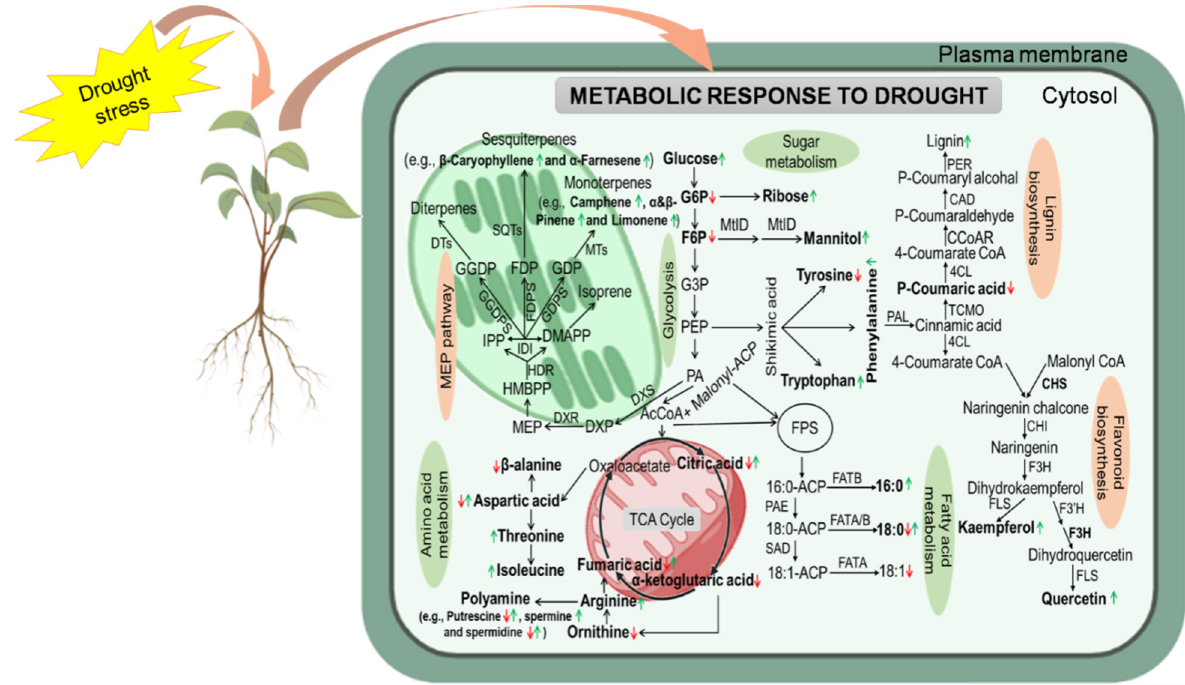
Figure 1. A schematic representation of metabolic response to drought stress. Primary metabolites (PMs) and secondary metabolites (SMs) are reprogrammed in plant cells to maintain osmotic balance and activate various primary and secondary metabolic pathways (green and orange circles, respectively) to survive under DS. Metabolites with an important role in DS are highlighted in bold, and their responses are depicted with green arrow (increased level), red arrow (decreased level), and green and red arrows (increased/decreased levels). ACP, acyl carrier protein; 4 CL, 4-coumarate-CoA ligase; AcCoA, acetyl-CoA; CAD, cinnamyl alcohol dehydrogenase; CCoAR, cinnamoyl-CoA reductase; CHI, chalcone isomerase; CHS, chalcone synthase; DMAPP, dimethylallyl diphosphate; DTs, diterpene synthase; DXP, 1-deoxy-D-xylulose-5-phosphate; DXS, 1-deoxy-D-xylulose 5-phosphate synthase; FAT A/B, fatty acyl-ACP thioesterase A/B; F3H, flavanone 3-hydroxylase, F3’H, flavonoid 3‘-hydroxylase; F6P, fructose 6-phosphate; FDP, farnesyl diphosphate; FDPS, farnesyl diphosphate synthase; FLS, flavonol synthase; G3P, glyceraldehyde 3-phosphate; G6P, glucose 6-phosphate; GDP, geranyl diphosphate; GDPS, geranyl diphosphate synthase; GGDP, geranyl geranyl diphosphate; GGDPS, geranyl geranyl diphosphate synthase; HDR, 1-hydroxy-2-methyl-2-(E)-butenyl 4-diphosphate reductase; HMBPP, 1-hydroxy-2-methyl-2-(E)-butenyl 4-diphosphate; IDI, isopentenyl diphosphate isomerase; IPP, isopentenyl diphosphate; MtID, mannitol-1-phosphate dehydrogenase; MEP, 2-C-methyl-D-erythritol-4-phosphate; MTs, monoterpene synthase; PAE, palmitoyl-ACP elongase; PA, pyruvic acid; PAL, phenylalanine ammonia-lyase; PEP, phosphoenolpyruvate; PER, peroxidase; SAD, stearoyl-ACP desaturase; SQTs, sesquiterpene synthase; TCA, tricarboxylic acid; TCMO, trans-cinnamate 4-monooxygenase. Figure adapted from images created with BioRender.comto draw the proposed model (https://app.biorender.com/biorender-templates (accessed on 18 June